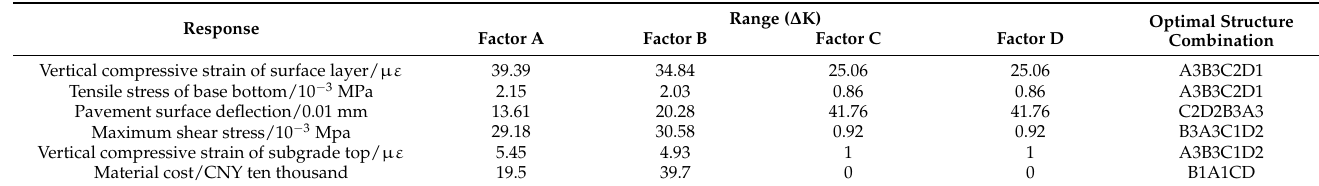
Table 6. Orthogonal data processing